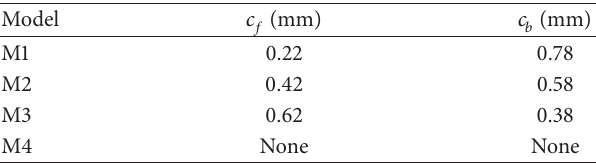
Table 2: Research